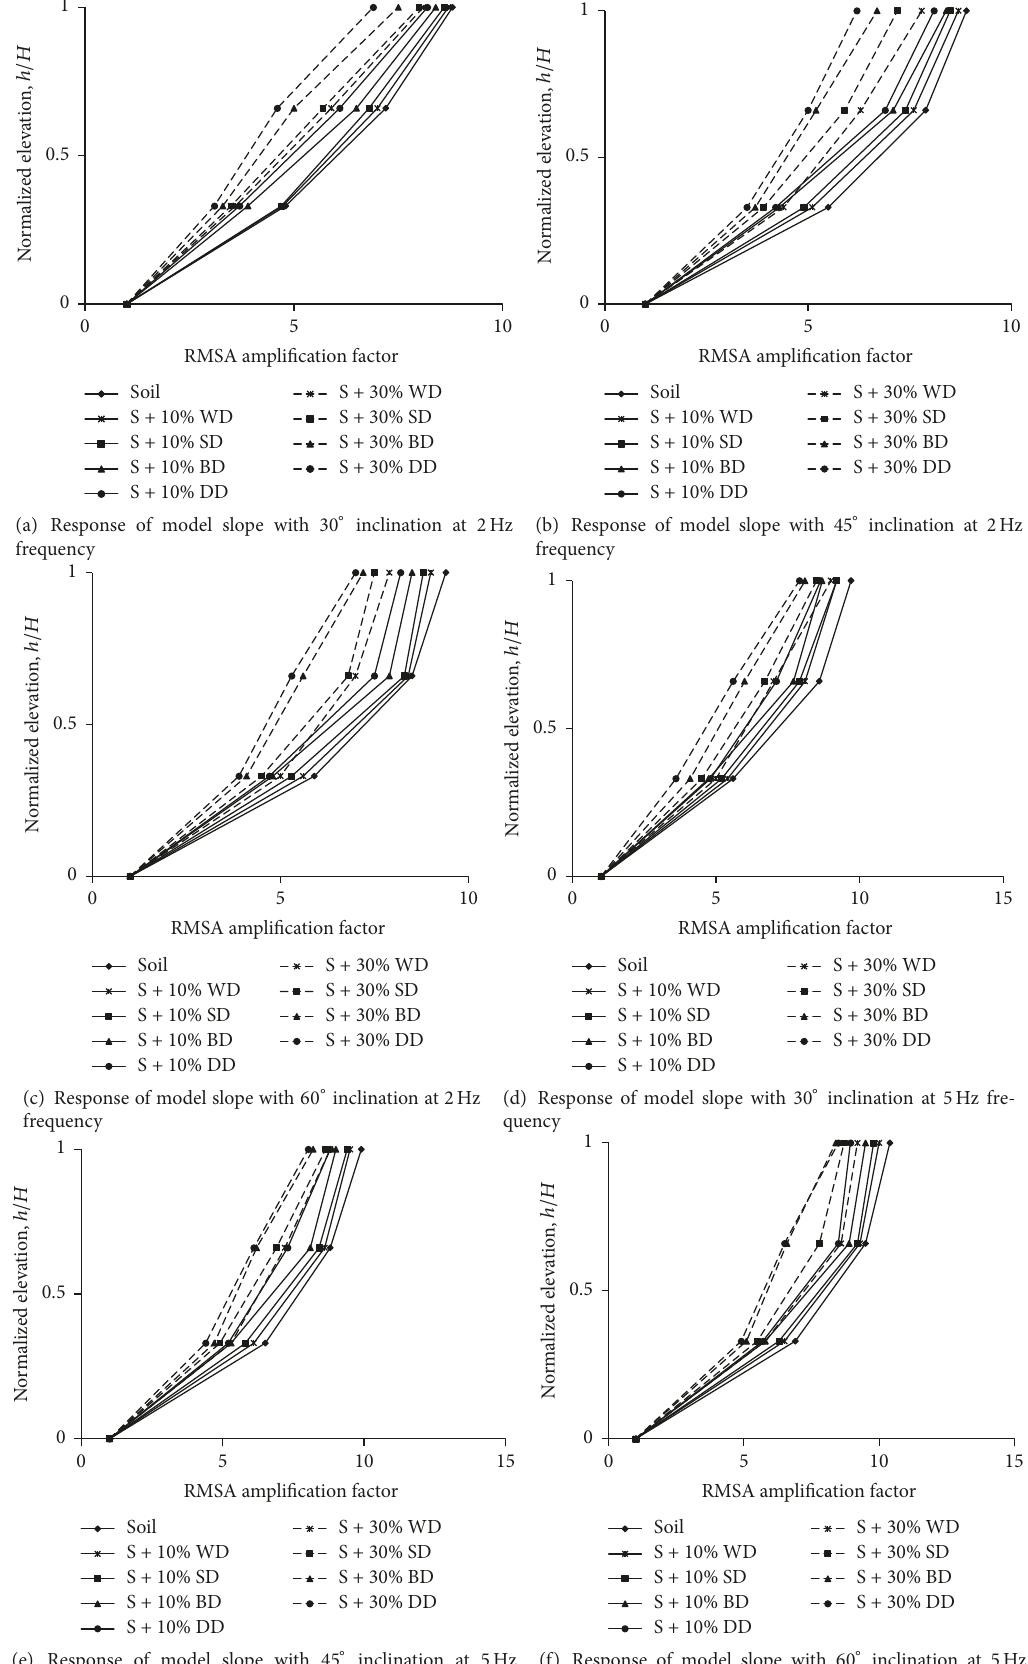
Figure 8: Response of slope made up of soil and soil dust mixtures at frequency of input motion 2Hz and 5Hz for air dried